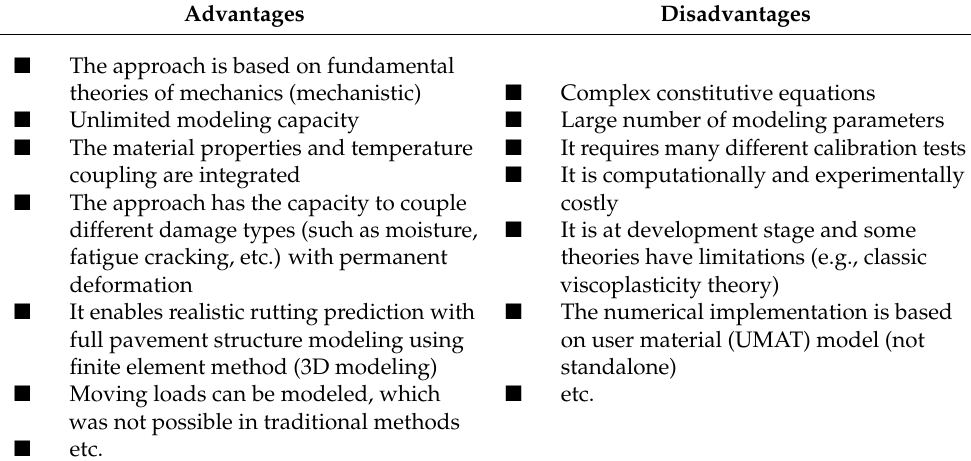
Table 3. Advantages and limitations of the PANDA